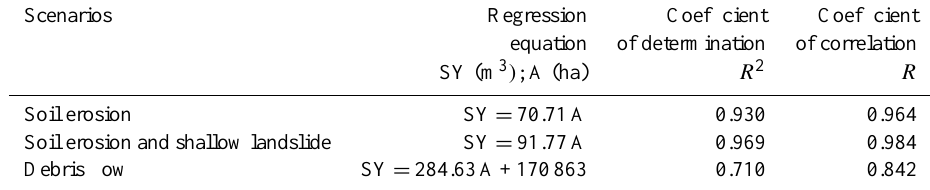
Table 2. The Results of Regression Analysis.